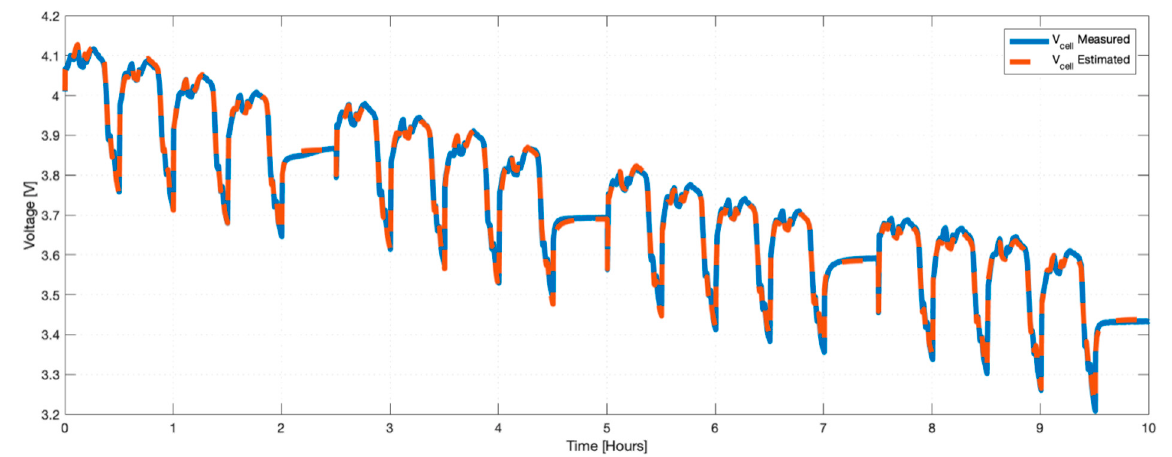
Figure 7. Cell I: Voltage measured versus estimated.